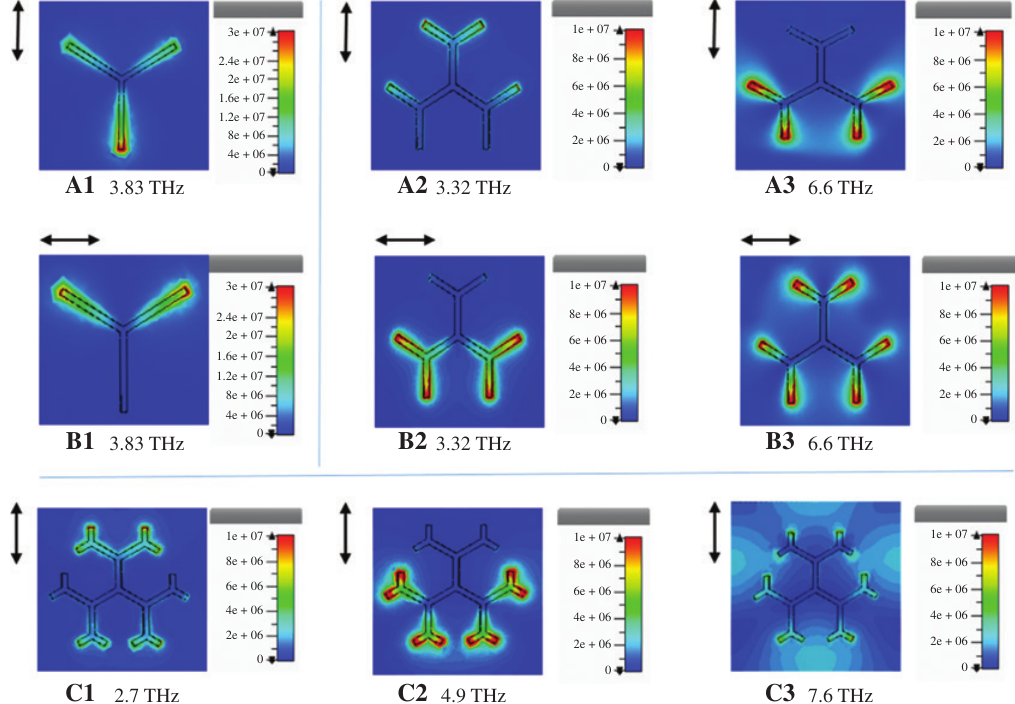
Figure 3: Electric field maps of first-, second-, and third-fractal-order Cayley tree structures at each resonance peak. The structure is illuminated with linearly polarized plane waves propagating in the z direction with the electric field vector in the x - y plane. (A1, B1) First-order Cayley tree for TE and TM polarization, respectively. (A2, A3) Second-order Cayley tree for TE polarization. (B2, B3) Second-order Cayley tree for TM polarization. (C1–C3) Third-order Cayley tree at various extinction peaks for TE polarization.